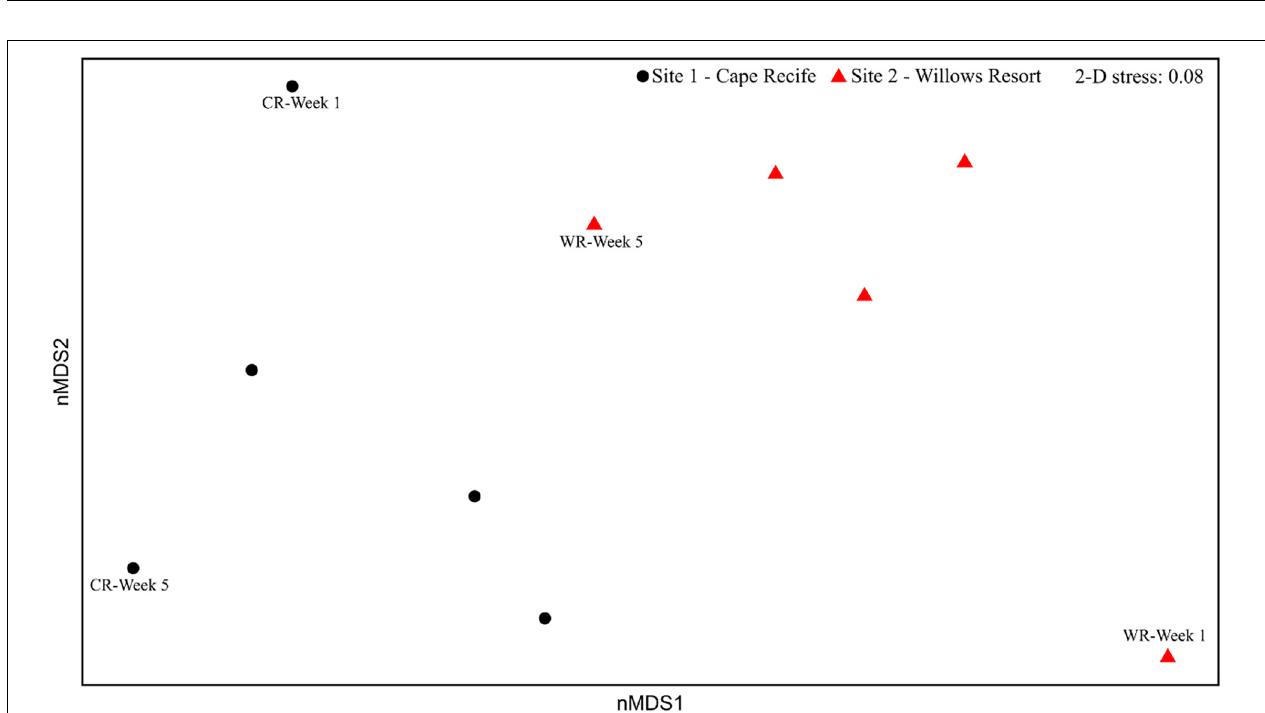
FIGURE 3 | Non-metric multidimensional scaling ordination of diatom assemblages at Cape Recife ( black circles ) and Willows Resort ( red triangles ).